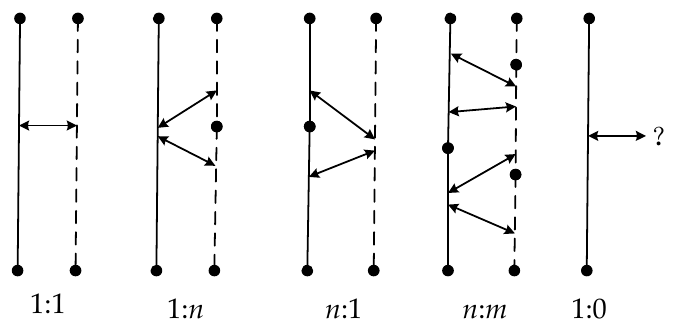
Figure 2. Cardinality of the matching pairs.